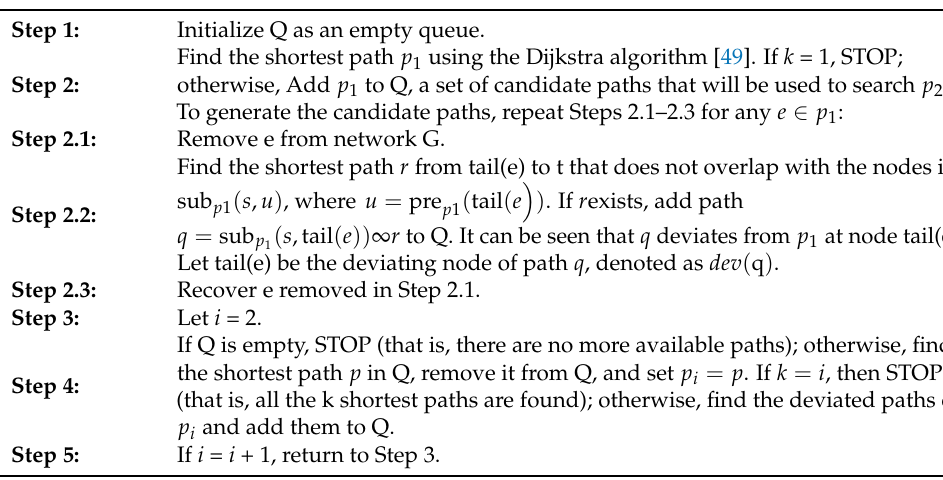
Table 1. Steps of the Yen